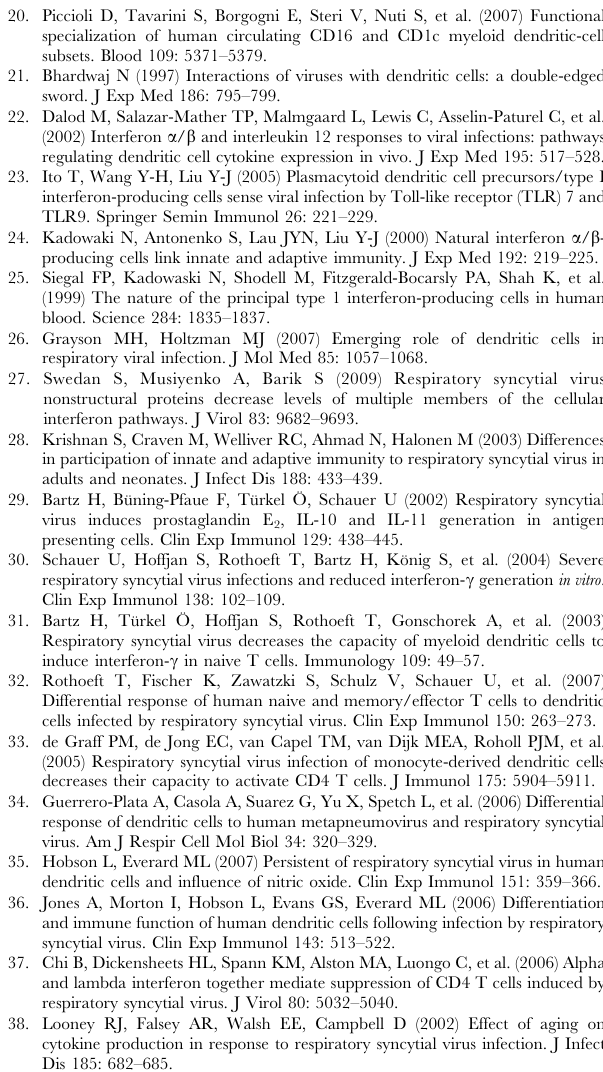
p , 0.01 and are denoted by bold blue values in gray shaded boxes while weak negative correlations are defined as r . 0 and